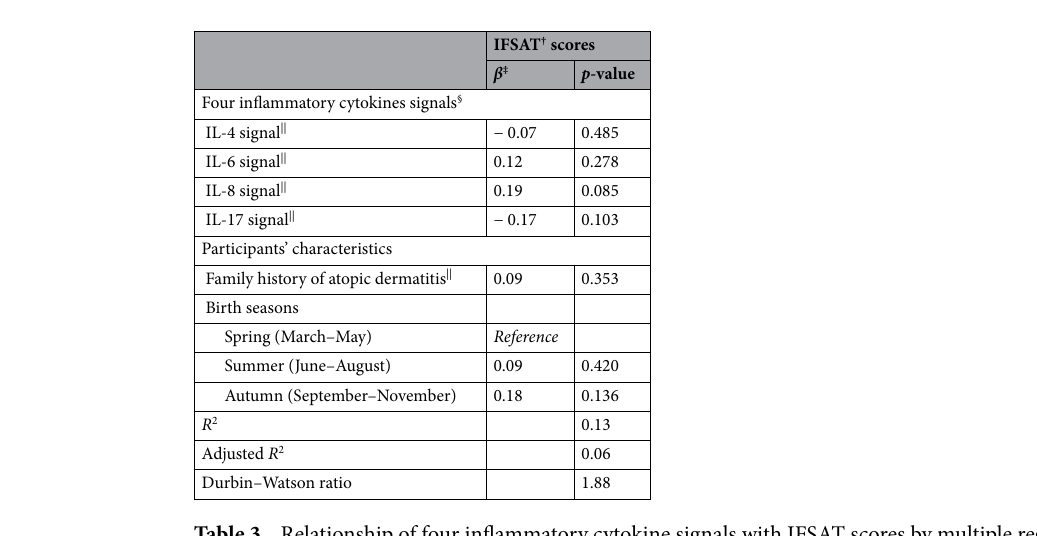
Table 3. Relationship of four inflammatory cytokine signals with IFSAT scores by multiple regression analysis (n = 96). ‡ Standardized coefficient beta, § Evaluating by skin blotting methods, || Negative = 0, Positive = 1. IFSAT infant facial skin visual assessment tool, IL